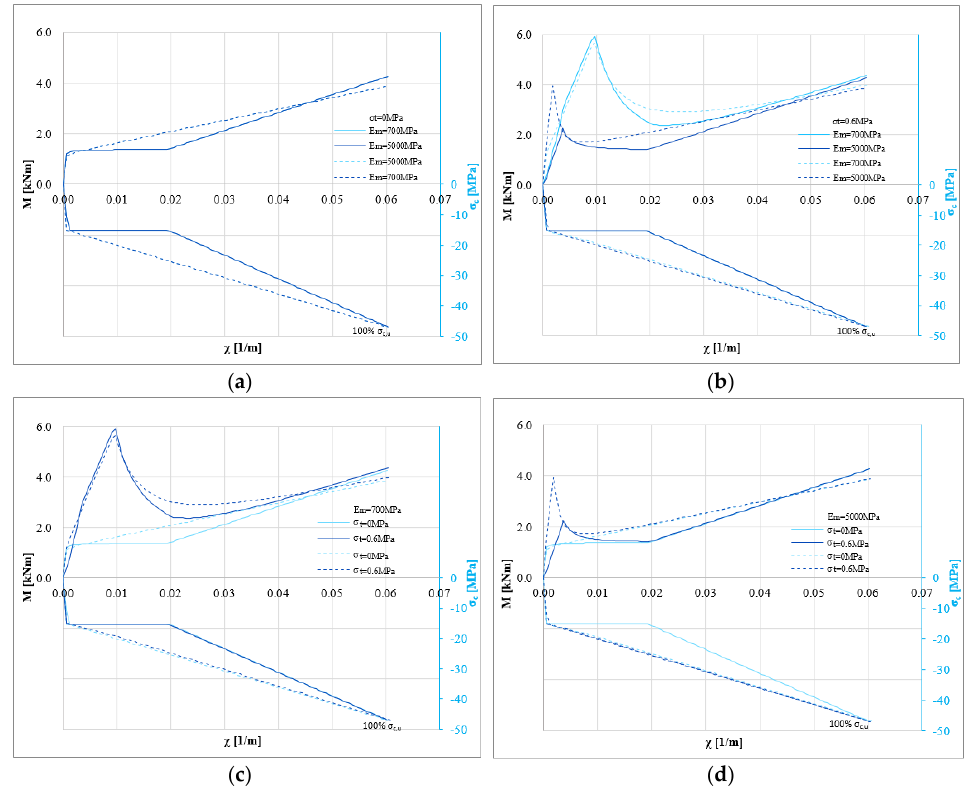
Figure 8 . M- χ and σ c,u - χ diagrams: P = 0 N, σ 0 = 8 MPa, σ t = 0 and 0.6 MPa, E m = 700 and 5000 MPa for tri-linear (solid lines) and bi-linear (dotted lines) relationships for the strengthening system (hemp fiber): ( a ) σ 0 = 8 MPa, σ t = 0 MPa changing E m ( b ) σ 0 = 8 MPa, σ t = 0.6 MPa to changing E m ( c ) σ 0 = 8 MPa, E m = 700 MPa changing σ t ( d ) σ 0 = 8 MPa, E m = 5000 MPa changing σ t .